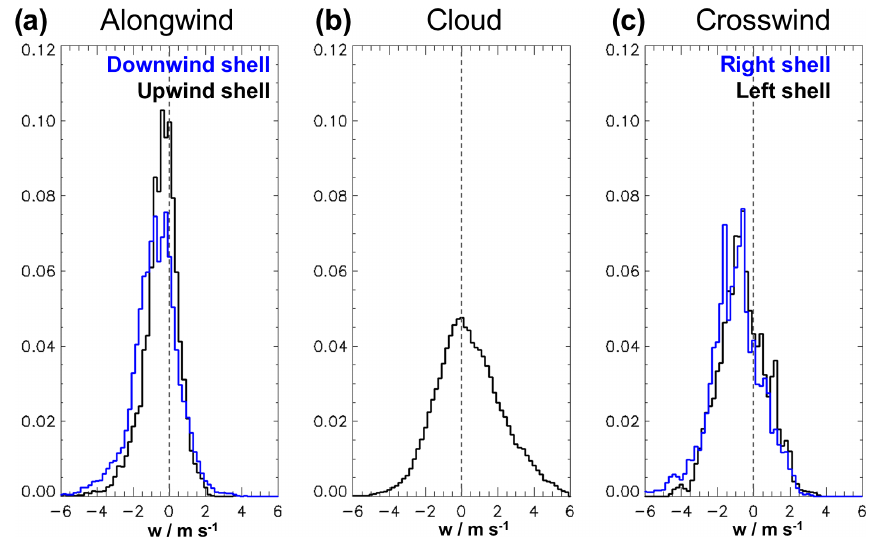
Figure 9. Distribution of the vertical wind in the cloud and shell regions for the 191 cloud transects. The three panels show the probability density function for (a) the upwind shell and the downwind shell; (b) the cloud; and (c) the right shell and left shell for the crosswind transects. For the distribution we set a bin size of 0 . 2ms − 1 and the results are scaled with the number of data points. The width of each shell is set to 20% of the respective cloud diameter.